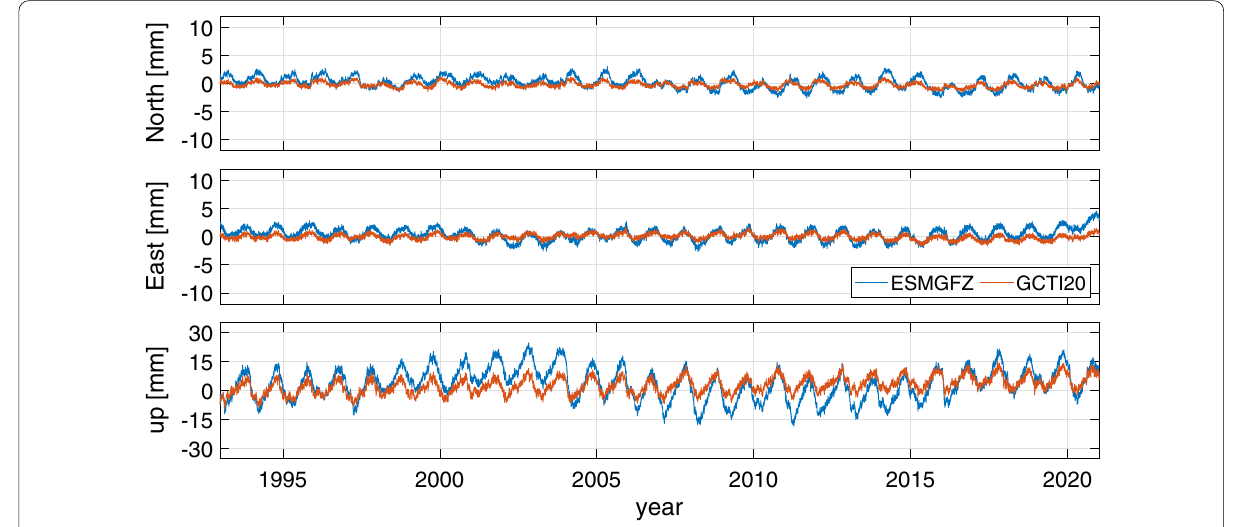
Fig. 6 Same as Fig. 5, but this time the site displacements refer to the